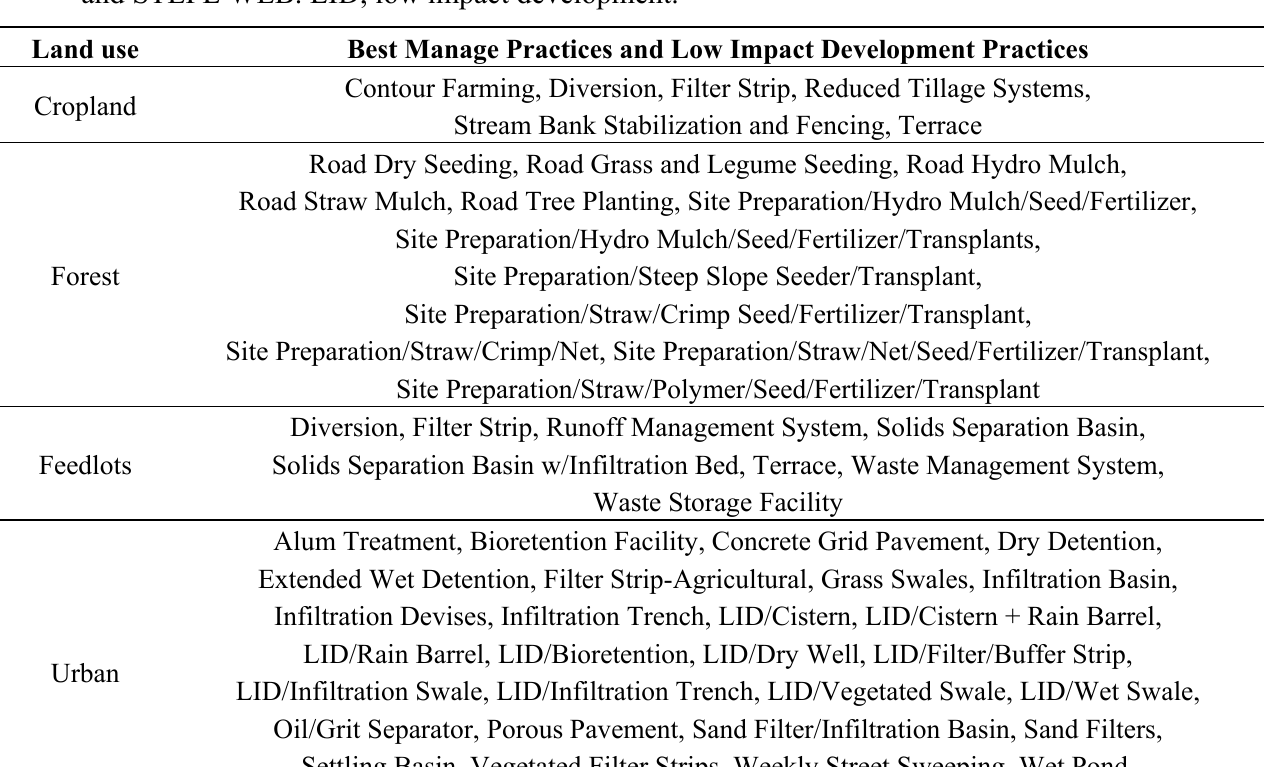
Table 2. Best management practices and low impact development practices in EPA STEPL and STEPL WEB. LID, low impact